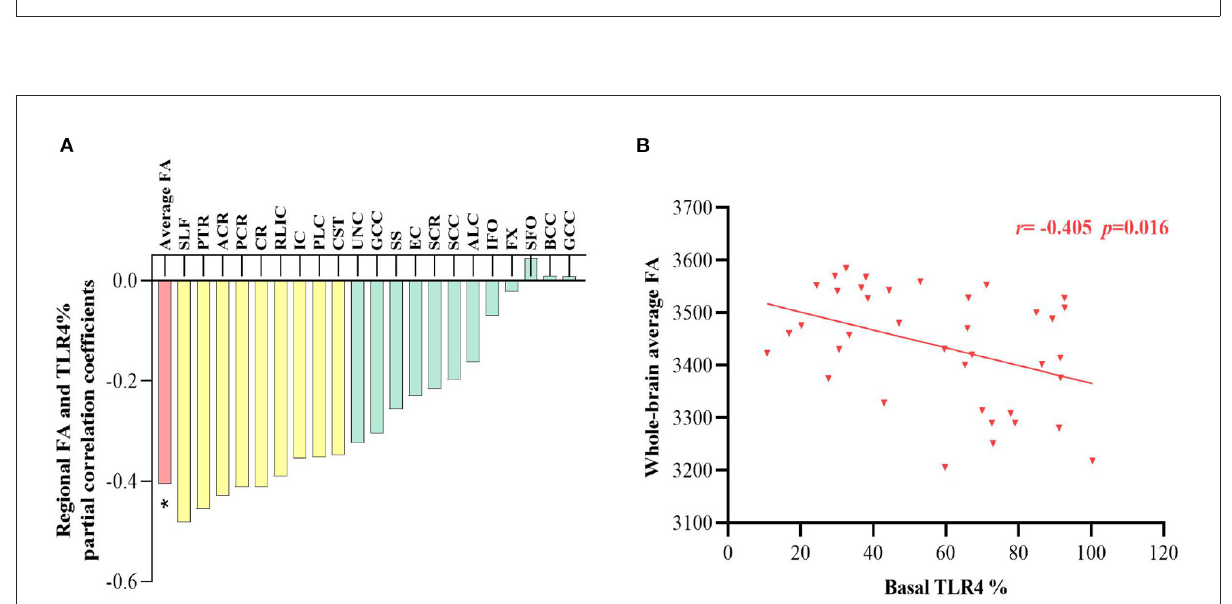
FIGURE3 (A) Partial correlation coefficients between TLR4% and white matter FA in patients after adjusting for age, sex and intracranial volume, and nominal correlations after multiple comparison ( p > 0.05/21 = 0.002) were drawn in yellow. (B) The correlation between TLR4 % and whole-brain average FA is plotted. TLR4, Toll-like receptor 4; FA, fractional anisotropy. %, The percentage of monocytes * p <